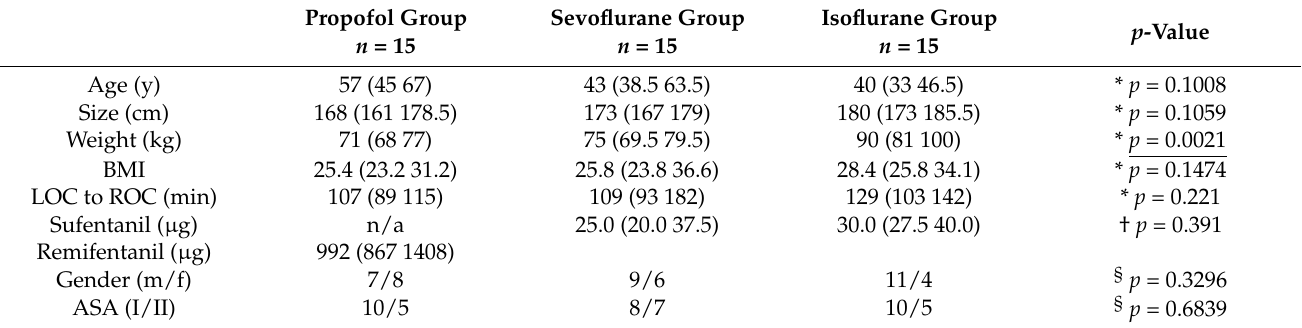
Table 1. Patient characteristics data of the three patient